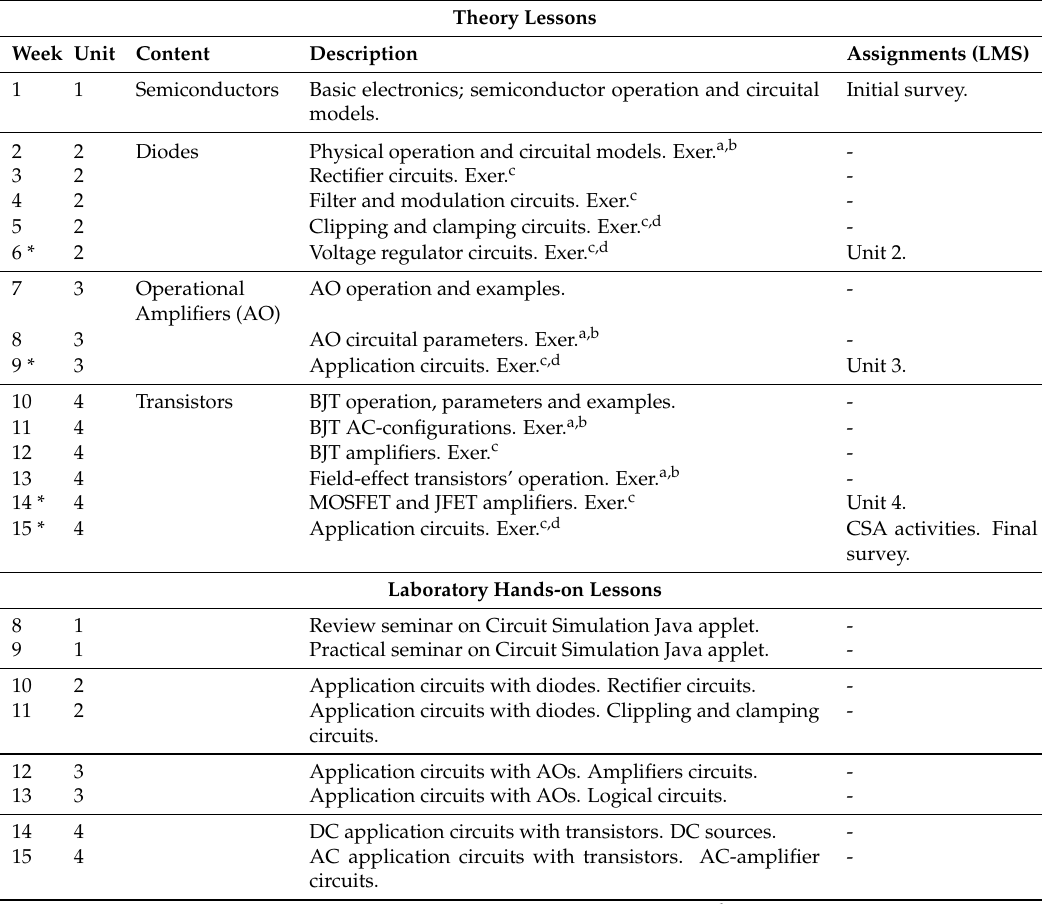
Table 1. Course structure: schedule with theory and practical lessons, contents, assignments and use of